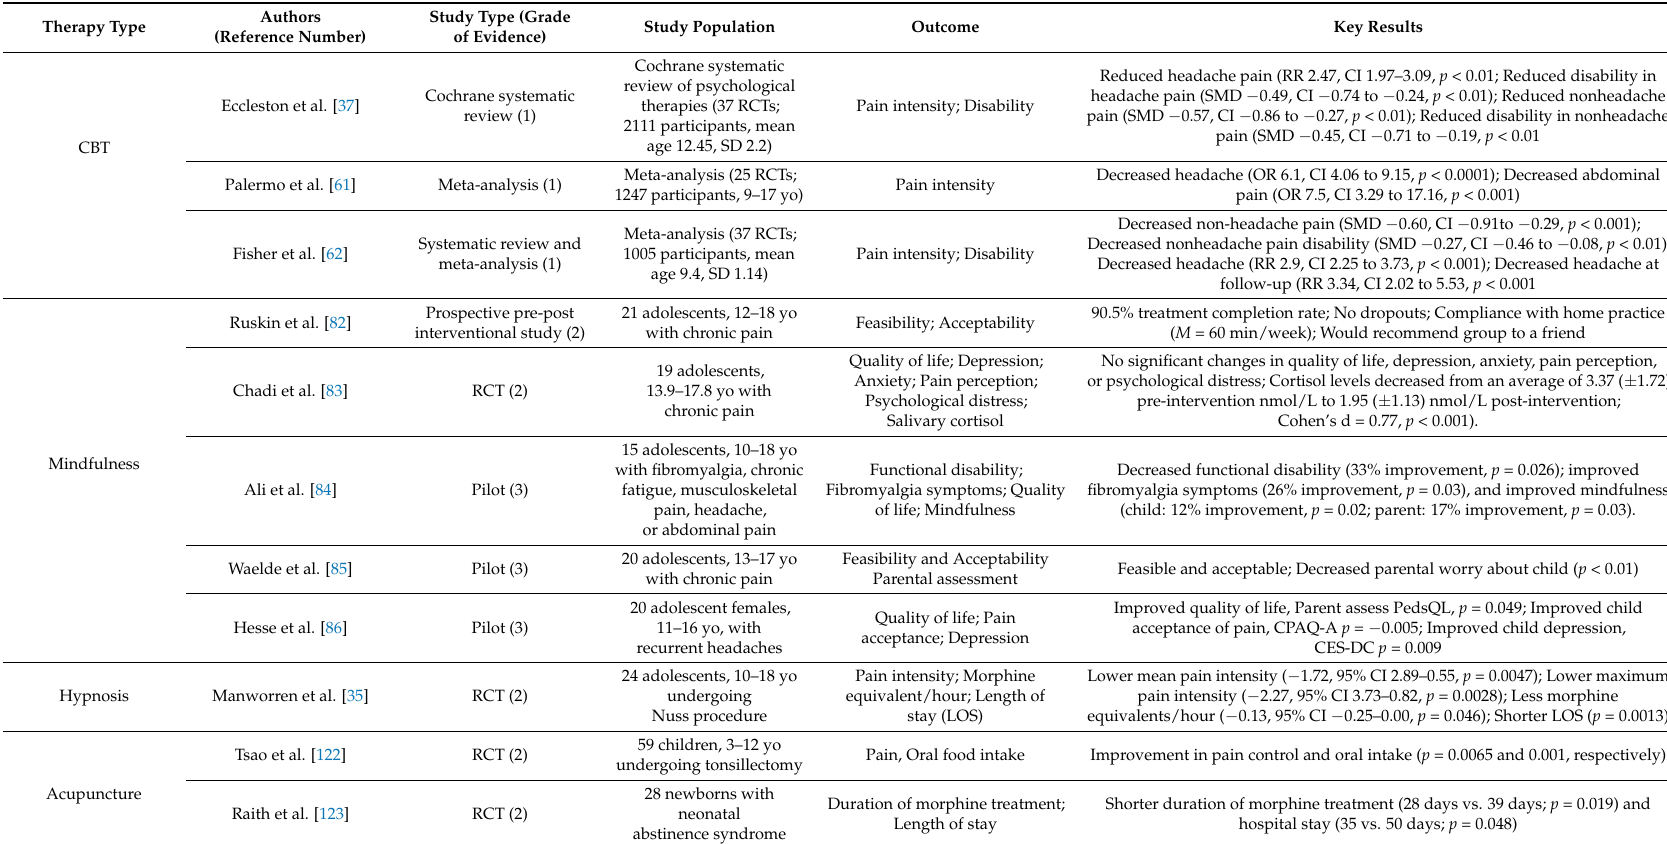
Table A1. Selection of important studies in pediatric integrative non-pharmacological therapies reviewed for this paper. From all the articles screened, the articles with the highest level of evidence are summarized